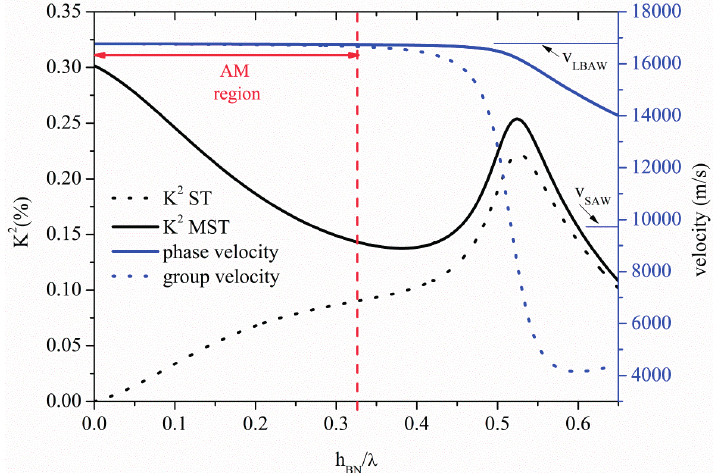
Figure 4. Phase and group velocity, and K 2 dispersion curves of the S 0 mode propagating along the MST and ST configurations on BN